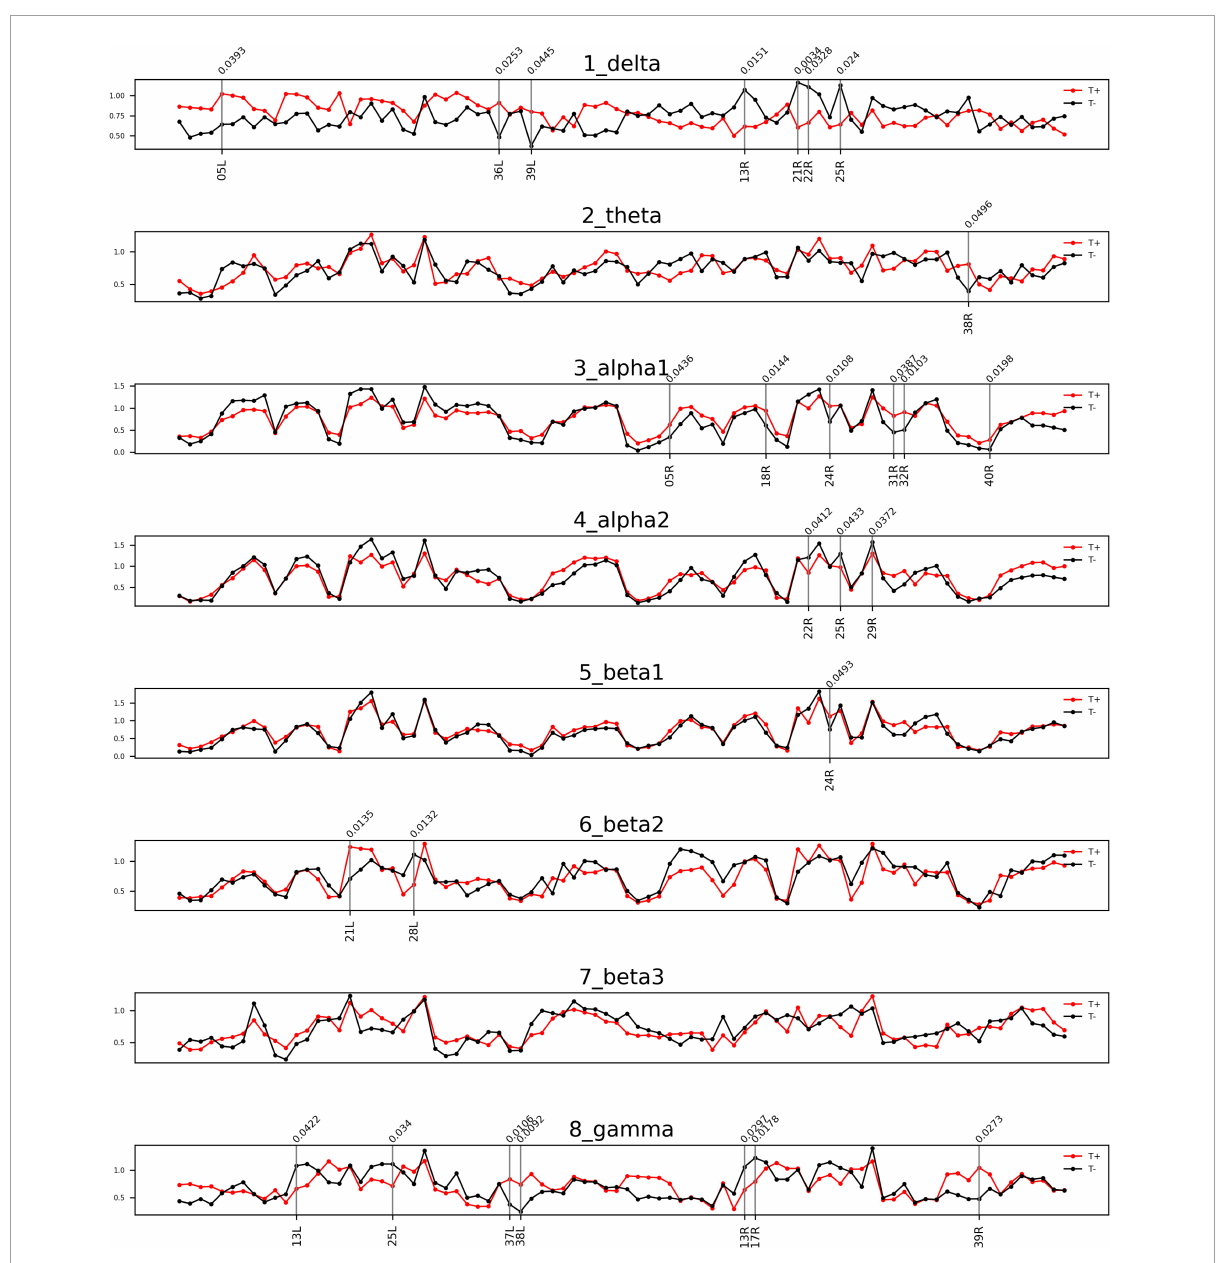
FIGURE2 Frequency bands in Brodmann areas (BAs) showing differences in afferent node capacity between the sudden sensorineural hearing loss patients with tinnitus (T) and sudden sensorineural hearing loss patients without tinnitus (NT) ( p < 0.05). The red and black lines represent the T and NT groups, respectively. The black vertical lines denote BAs in which the frequency bands showed significant group differences. The figures were generated using the Nilearn (version 0.2.5) Python